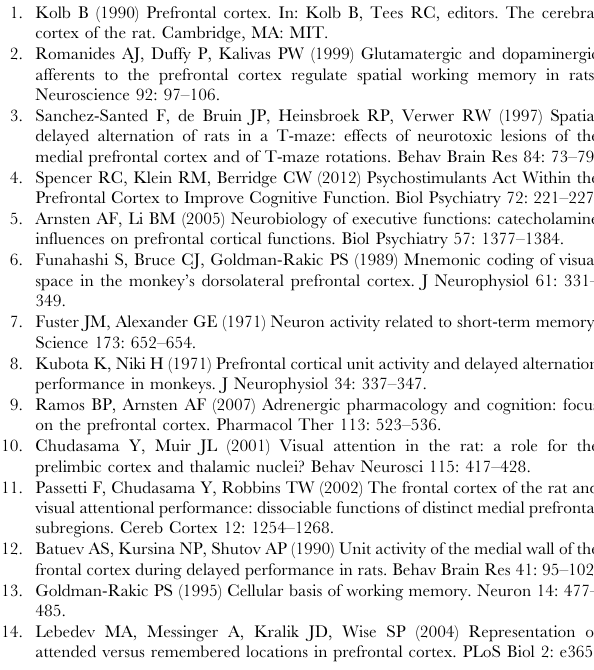
Figure S3 Kolmogorov–Smirnov test plots of pl PFC time- rescaled spike trains. Each panel represents K-S plots from each of six pl PFC neurons from three separate animals. The solid black diagonal line represents equivalency between the actual pl PFC spike train and l ( t D H t ) from the CI-GLM model. Dotted lines represent the 95% confidence intervals for equivalency measures. Inclusion of spiking history covariates into the model (blue line; Model 1a of main text) significantly improves l ( t D H t ) estimations from models that only include behavioral intervals (green line, model from Fig. 6B). Video S1 Video clip of electrophysiological recording while performing the T-maze task. Three trials are shown, a left-correct, a right-correct, and a right-incorrect. The green inset text denotes the animal ID, experimental time, and video frame